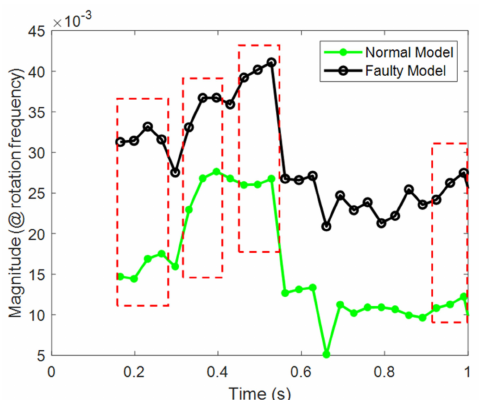
Figure 8. Magnitude at rotational frequency of 18 Hz over time with 0.33-s-length time window and 90% overlap. Case where impulsive noises are contained four times at 0.1, 0.4, 0.5, and 0.8